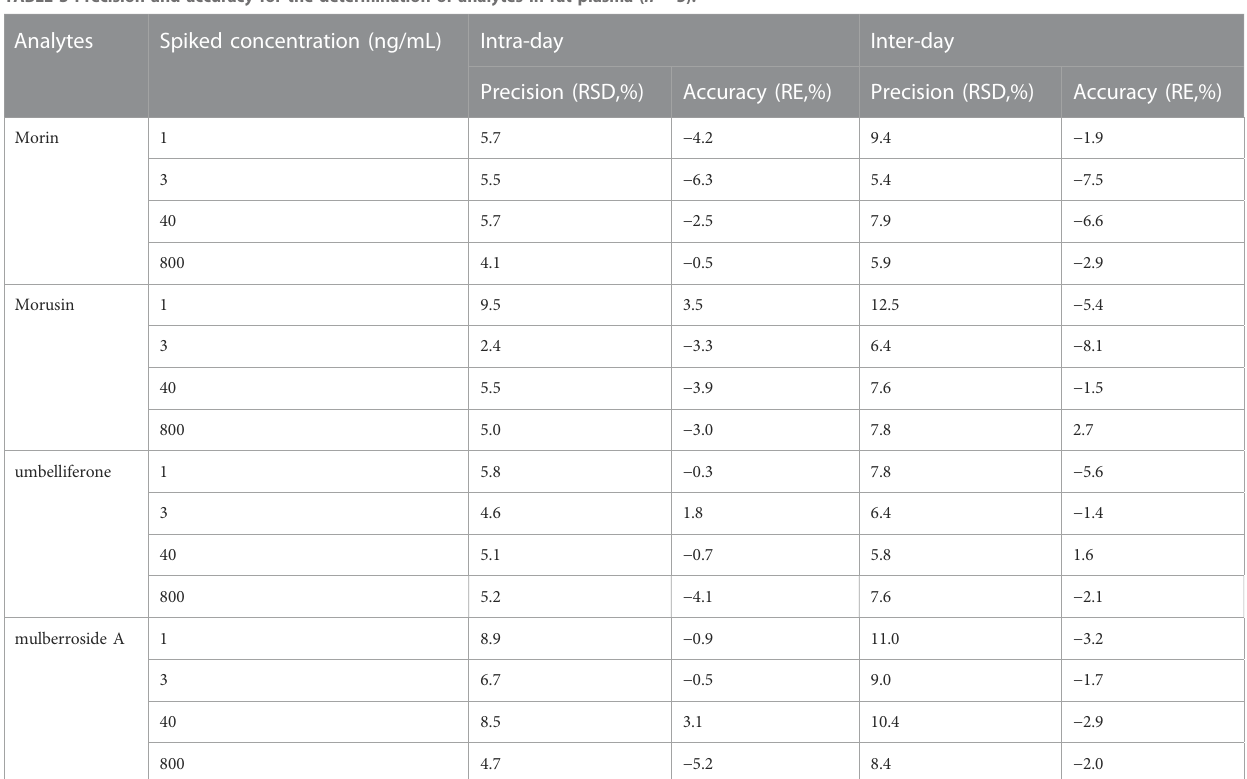
TABLE 3 Precision and accuracy for the determination of analytes in rat plasma ( n = 5). Analytes Spiked concentration